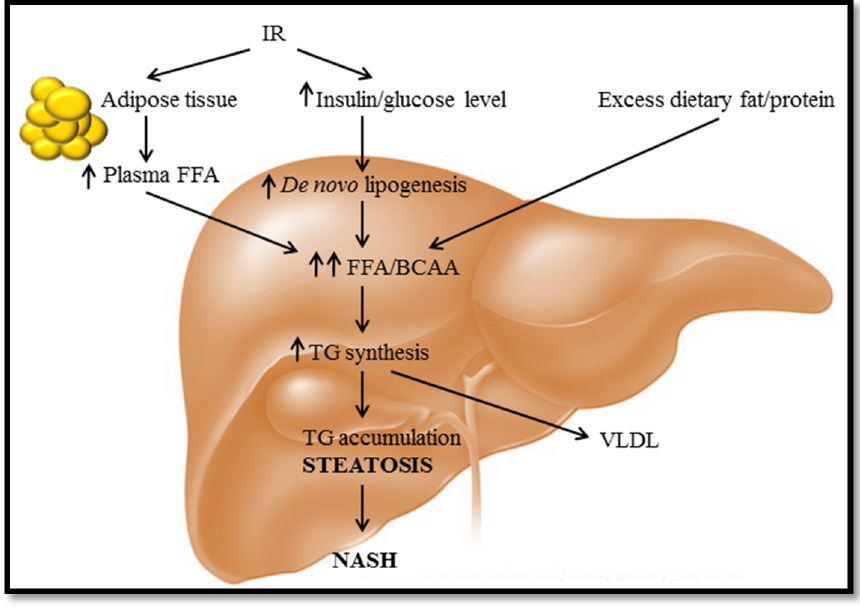
Figure 1. Hepatic triglyceride (TG) accumulation. FFAs are derived from the diet or synthesized de novo by hepatocytes. High levels of dietary protein intake (leading to increased circulating BCAA) can induce peripheral IR by inhibiting insulin signaling, resulting in increased uptake of glucose and TG storage in hepatocytes. Meanwhile, IR in adipose tissue reduces the inhibitory effect of insulin on lipoprotein lipase, resulting in increased lipolysis ( i.e. , breakdown of TG) and, thus, to increased circulating FAs to be taken up by the liver. Hyperinsulinemia can also induce de novo synthesis of FFAs in hepatocytes, leading to hepatic TG synthesis. These pathways drive hepatic TG accumulation and ultimately may contribute to the development of NASH. IR: insulin resistance; FFA: free fatty acid; BCAA: branched-chain amino acid; NASH: non-alcoholic steatohepatitis; VLDL: very low-density